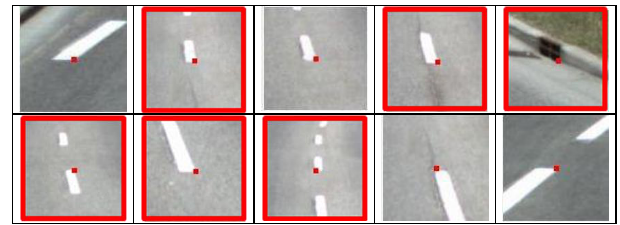
Figure 16. Matching results of type 5 dataset.